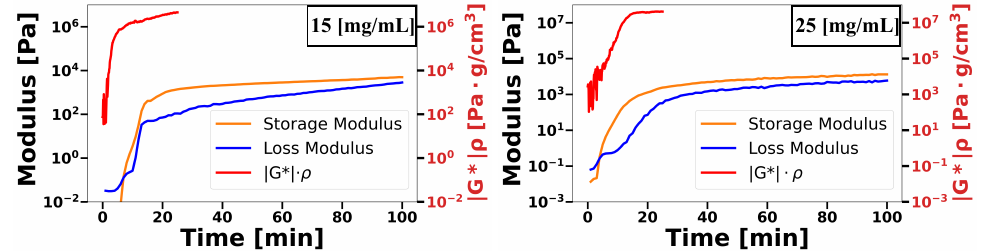
Figure 2. Comparison between rheological evaluation and complex modulus obtained from ∆ f and ∆Γ . ( left ) 15 mg/mL muc-gel; ( right ) 25 mg/mL muc-gel.